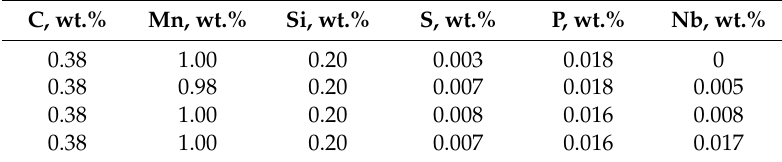
Table 2. Chemical composition of 0.38 wt.% carbon steel specimens (Weight Percent).